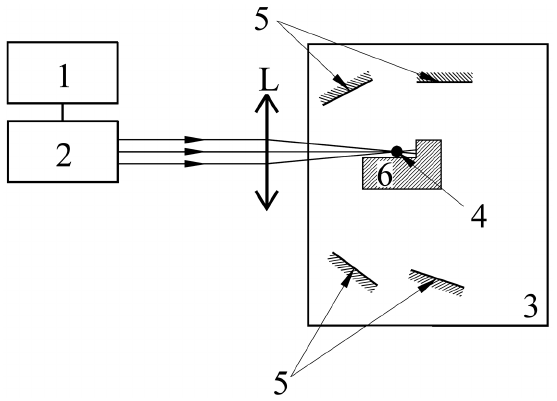
Figure 1. Schematic representation of the pulsed laser induced vaporization system [36]. 1: electro- optical system to tune the laser’s quality factor, 2: laser resonator chamber, L: laser radiation